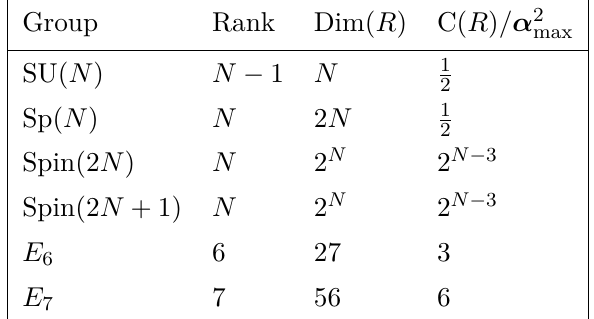
Table 2 . Groups with nontrivial centers: their ranks, dimension and Dynkin indices C ( R ) of the “convenient” representation, normalized by the length of the longest root